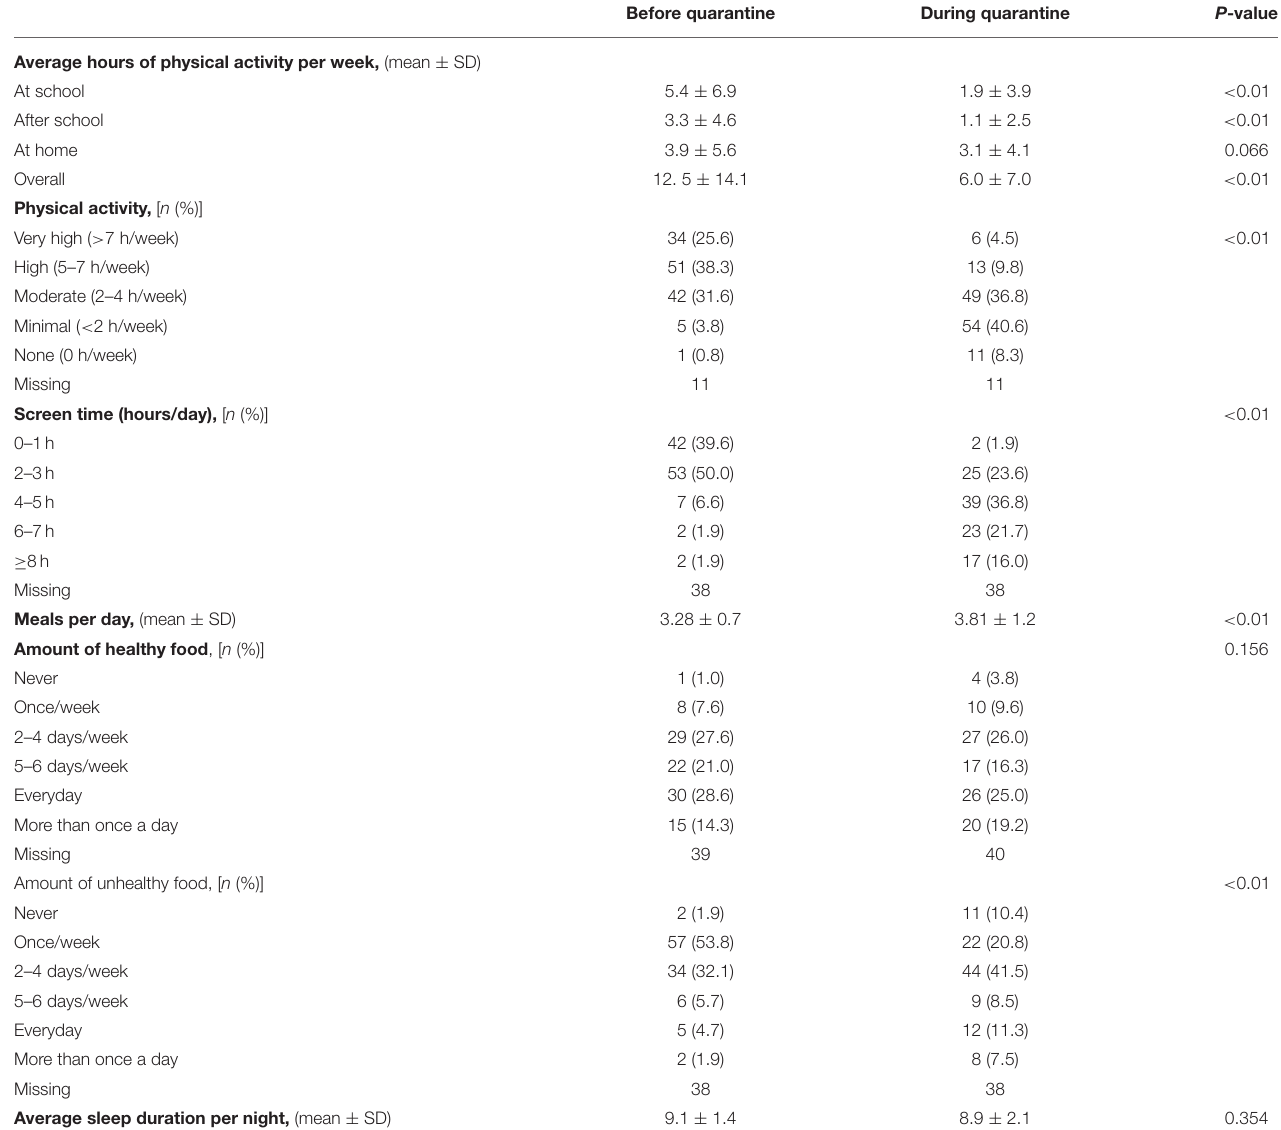
TABLE 2 | Comparison of the physical activity, screen time, dietary habits, and sleep before quarantine and during quarantine. Before quarantine During quarantine P -value Average hours of physical activity per week, (mean ±